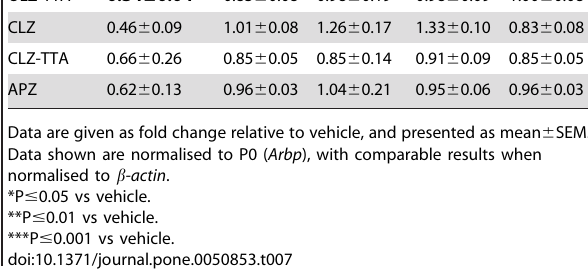
(Table 5). Corresponding transcriptional effects were observed for Cpt2 expression (Table 5). Enzymatic activity corroborated the transcriptional changes (Figure S1).